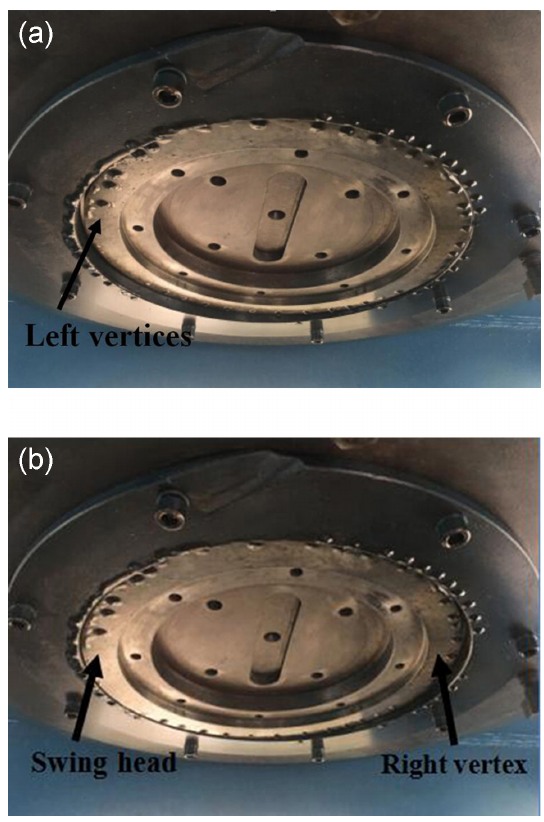
Figure 16. Swing head movement when ω 1 = − ω 2 ( e 1 + e 2 = 2 e